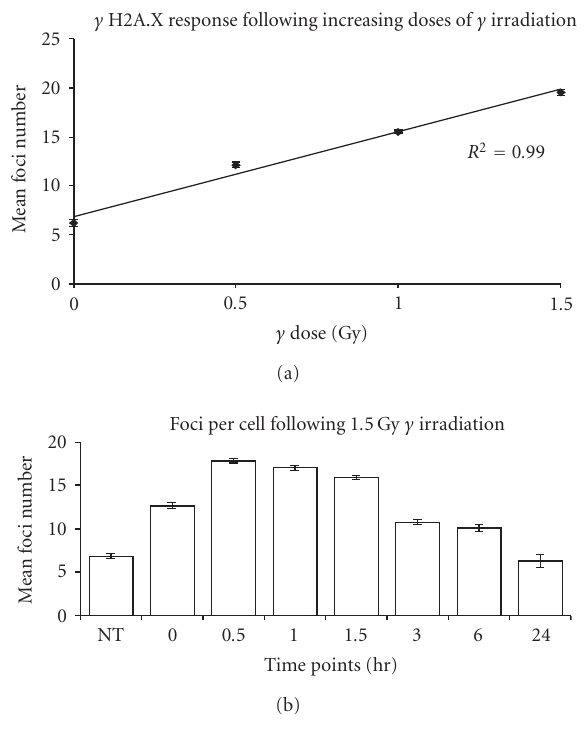
Figure 2: Preliminary dose- and time-response patterns based on control cell line GM12154 for the mean number of γ H2A.X foci following gamma irradiation. Two independent experiments, each containing two replicates ( ∼ 200 cells each), were used for the analyses. (a) Linear dose response at 0.5 hour following gamma irradiation ( R 2 = 0.99). Error bars represent ± 1 SEM for two experiments. (b) Non-linear time response to 1.5 Gy gamma irradiation. The time point, NT, represents preexposure cells. Error bars represent ± 1 SEM for two experiments.